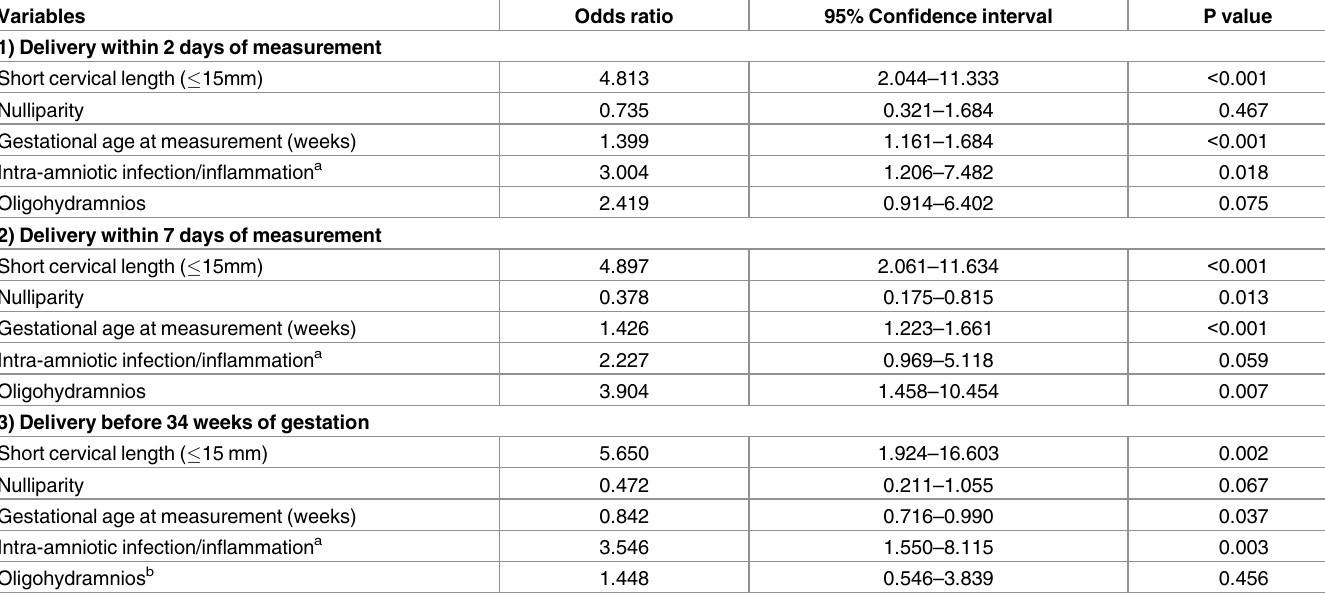
Table 3. Relationship of various independent variables with the risk of preterm birth analyzed by multiple logistic regression